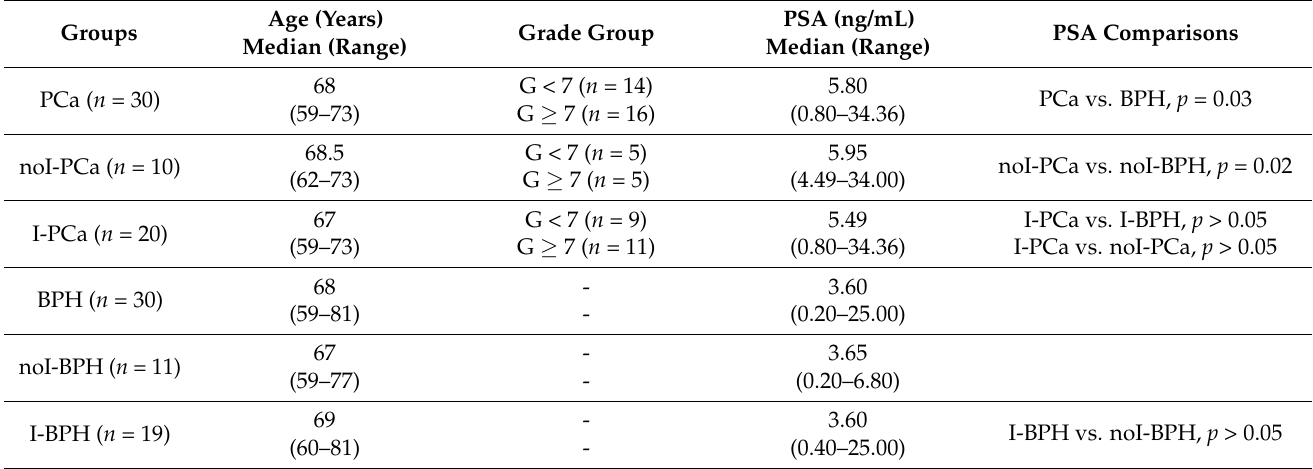
Table 1. Clinical data of selected patients.